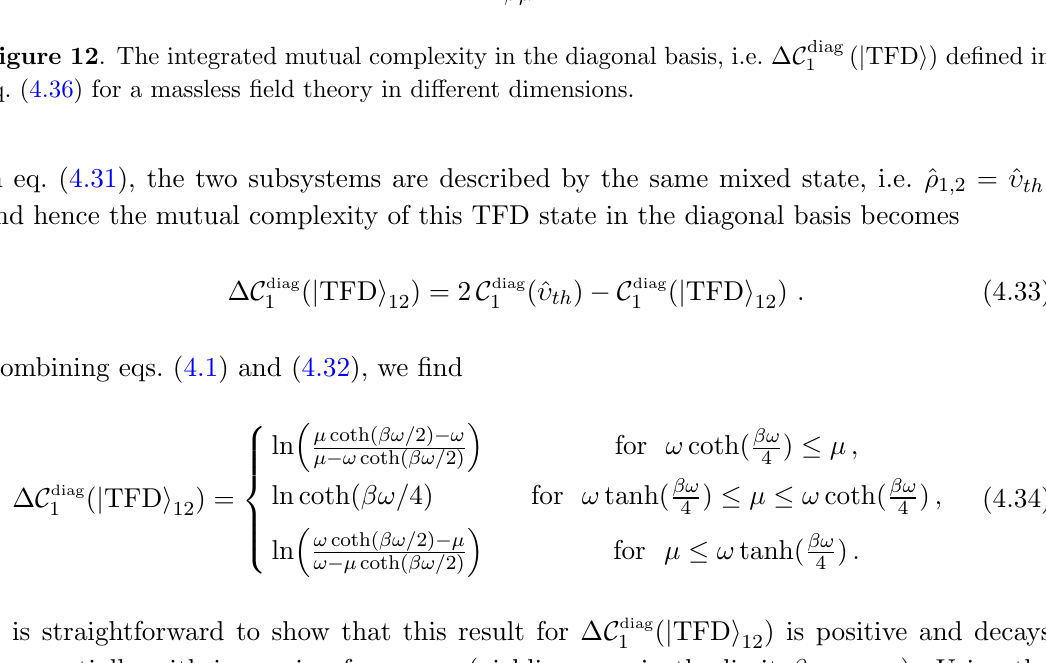
( j TFD i ) de(cid:12)ned in 1